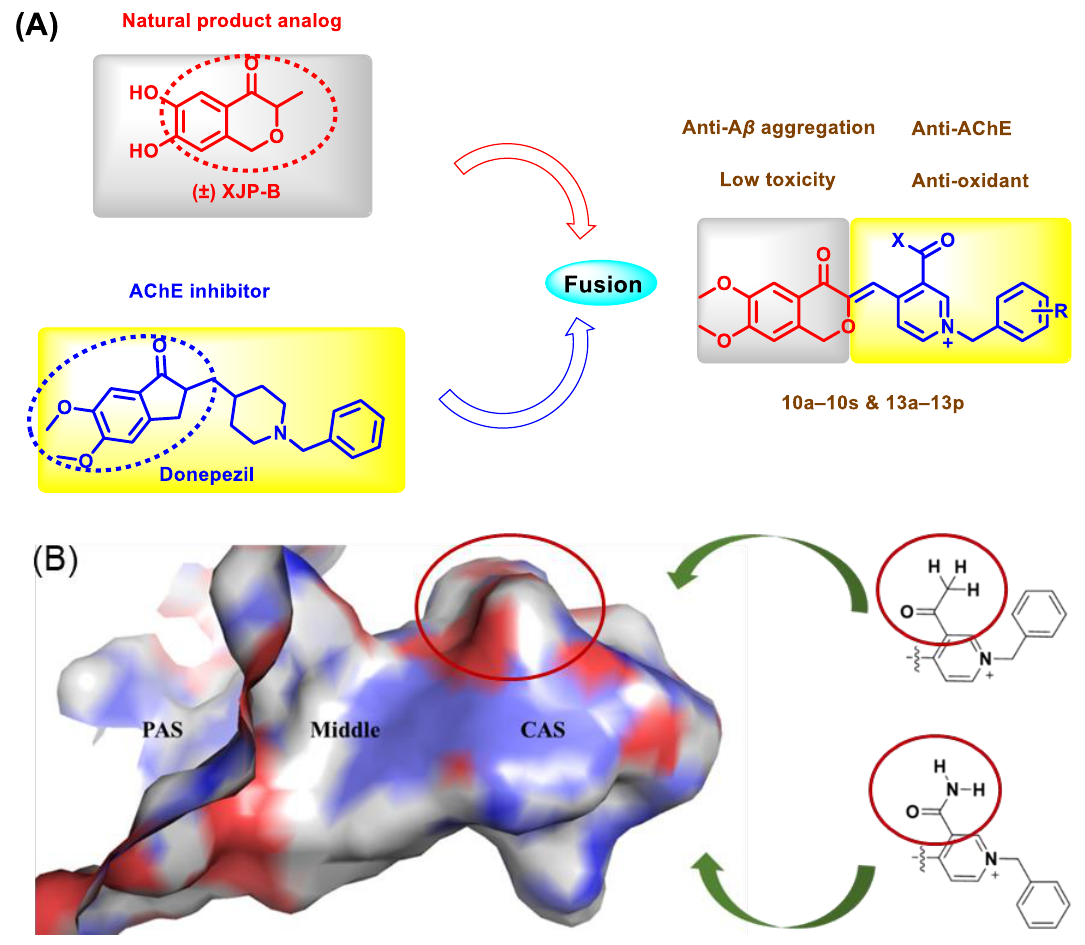
Figure 2. ( A ) Design strategy of the target compounds. ( B ) The pharmacophore of target compounds and the active pockets of AChE.